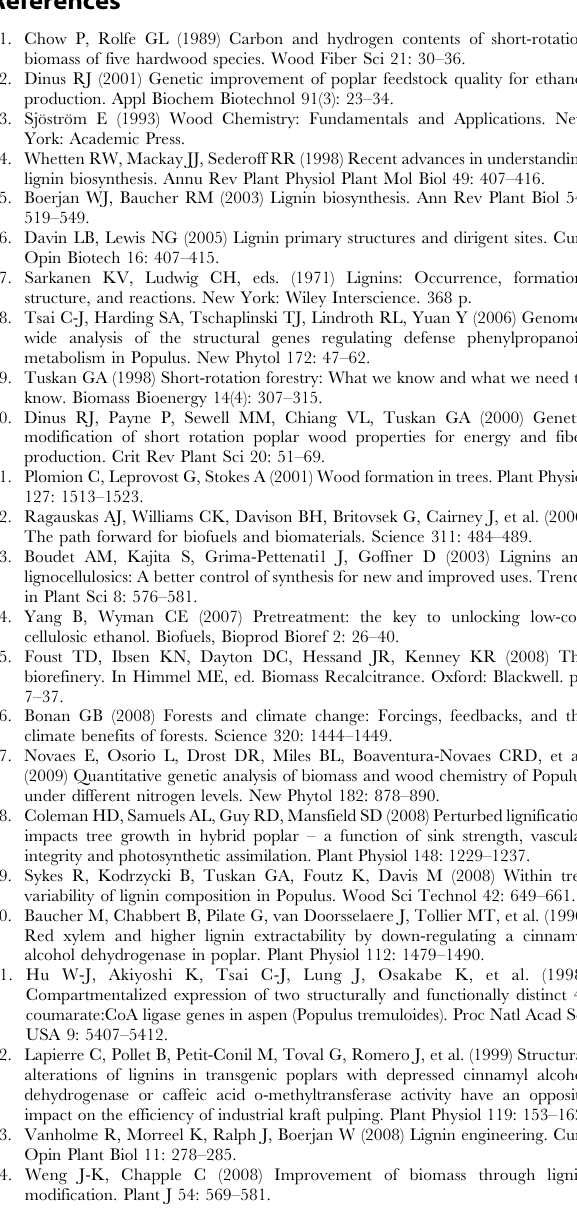
Table S4 Distribution test of QTLs among chromosomes of Populus by Poisson calculator. Table S5 Classification of the putative pleiotropic